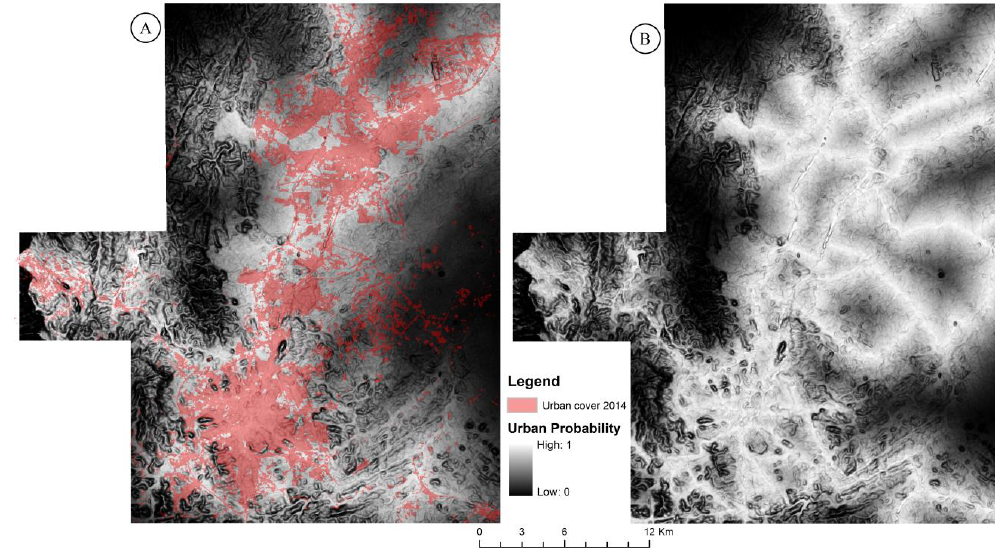
Figure 8. Urbanization probability maps in Al-Taif ( A ) a comparison of the urban probability in 1985 and urban areas in 2014; ( B ) urban probability in 2014.